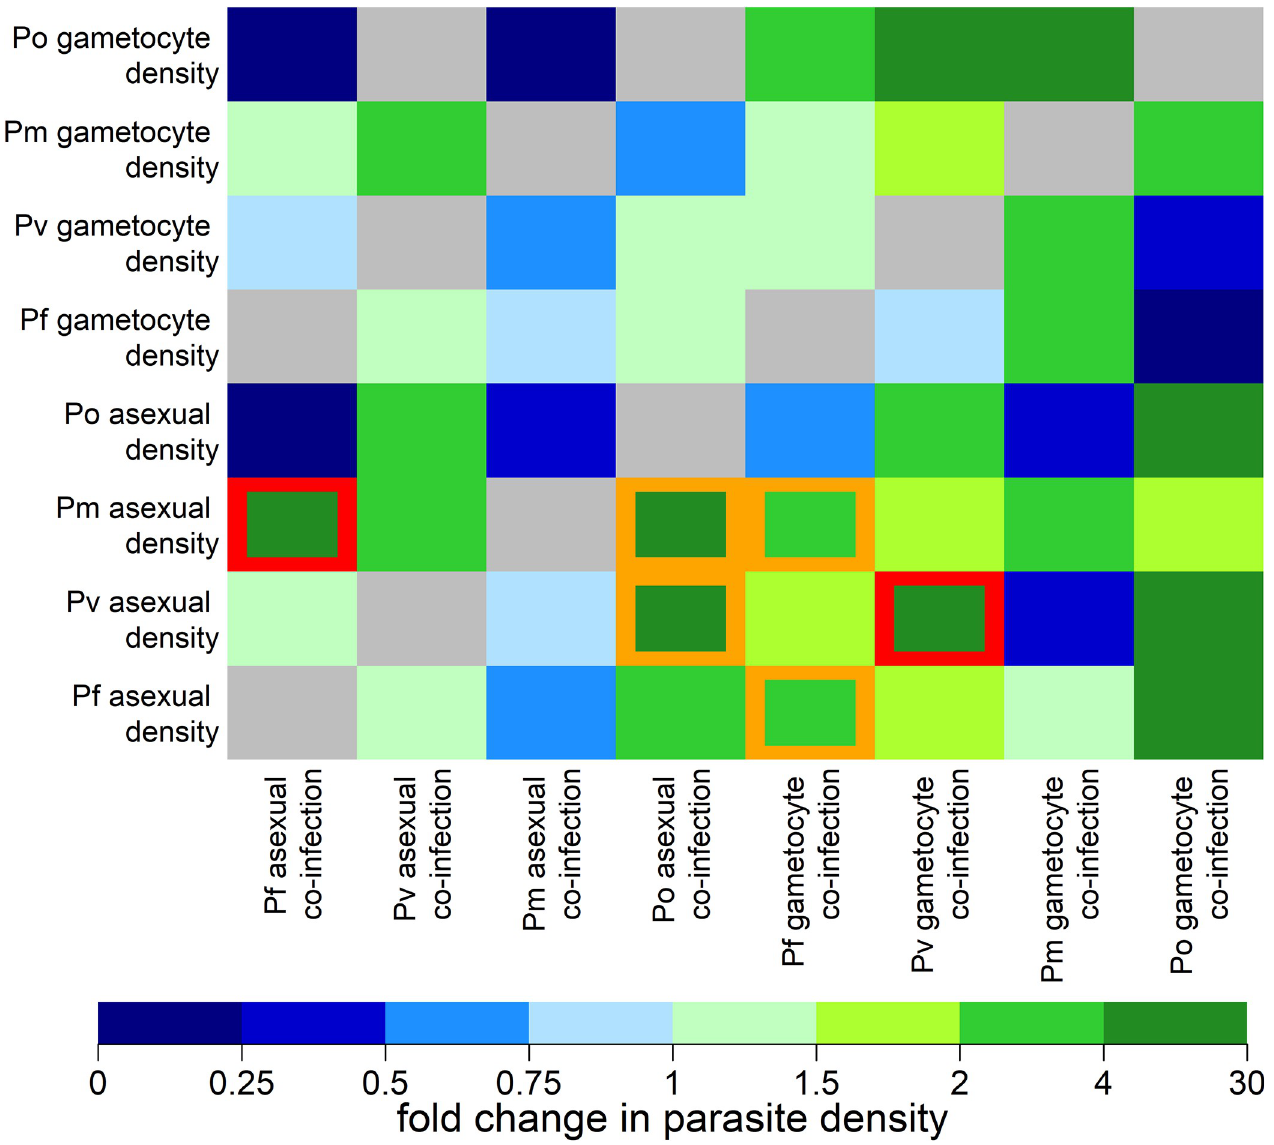
Fig 4. Effect of co-infection on parasite density in pre-treatment samples. The y-axis denotes the measured parasite density and the x-axis denotes the confounding effect of co-infection. Each square denotes the fold change in parasite density due to co-infection. For example, for Pm asexual parasites, co- infection with Pf asexual parasites leads to a 6.57 (2.9, 14.8) fold increase in Pm asexual parasite density. Grey squares denote interactions where it was not possible to estimate an effect. Otherwise, all estimated effects are presented regardless of statistical significance. Orange squares denote significant associations with P values < 0.05. Red squares denote significant associations with P values < 0.05 after the Benjamini-Hochberg adjustment for multiple hypothesis testing.